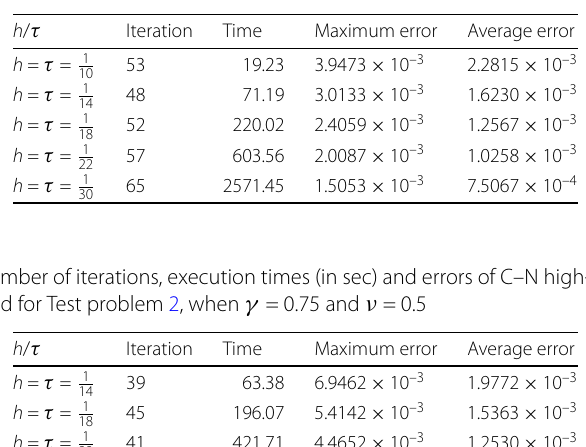
Table 9 The number of iterations, execution times (in sec) and errors of C–N high-order finite difference method for Test problem 1, when γ = 0.75